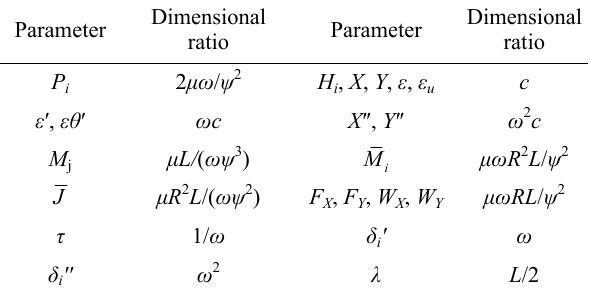
Note: The dimensional ratio refers to the ratio of normalized parameters to dimensionless